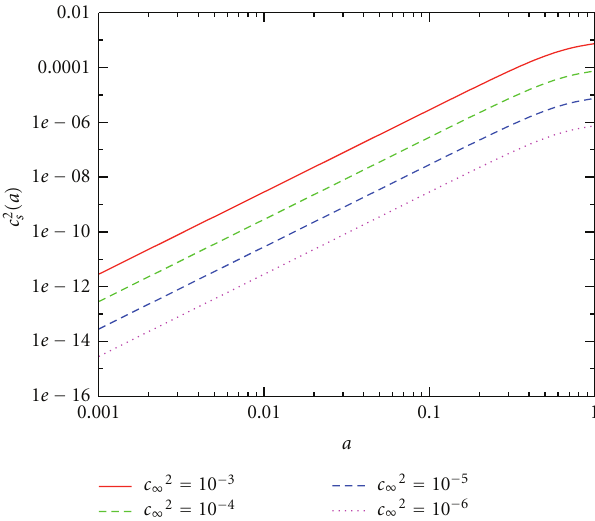
Figure 5: Sound speed c 2 ( a ) for di ff erent values of c ∞ 2 = s 10 − 6 ,10 − 5 ,10 − 4 ,10 − 3 from bottom to top (see [41]).